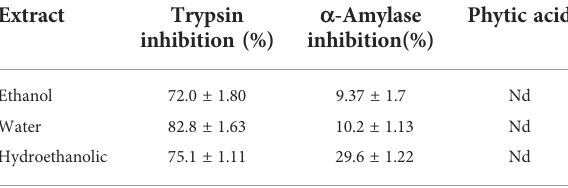
TABLE 3 Antinutrients and toxic factors in leaves of Limonium spathulatum . Extract